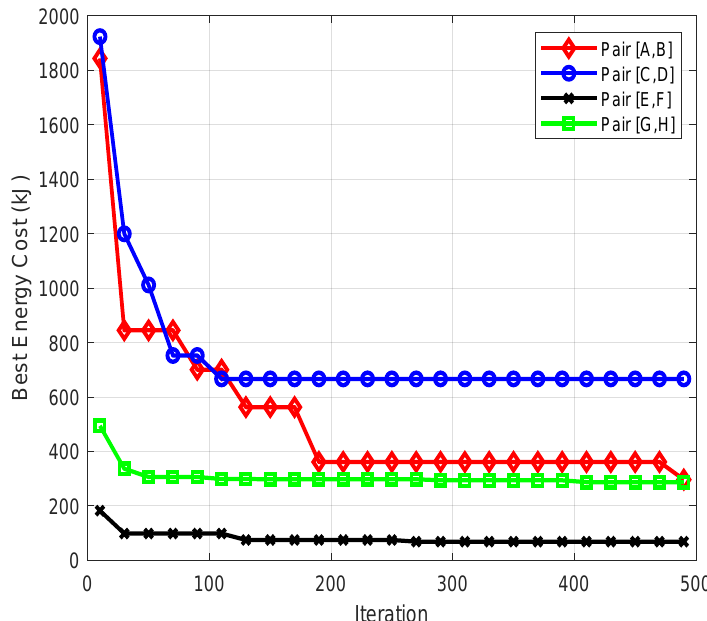
Figure 7. Convergence of the path energy vs. the ACO